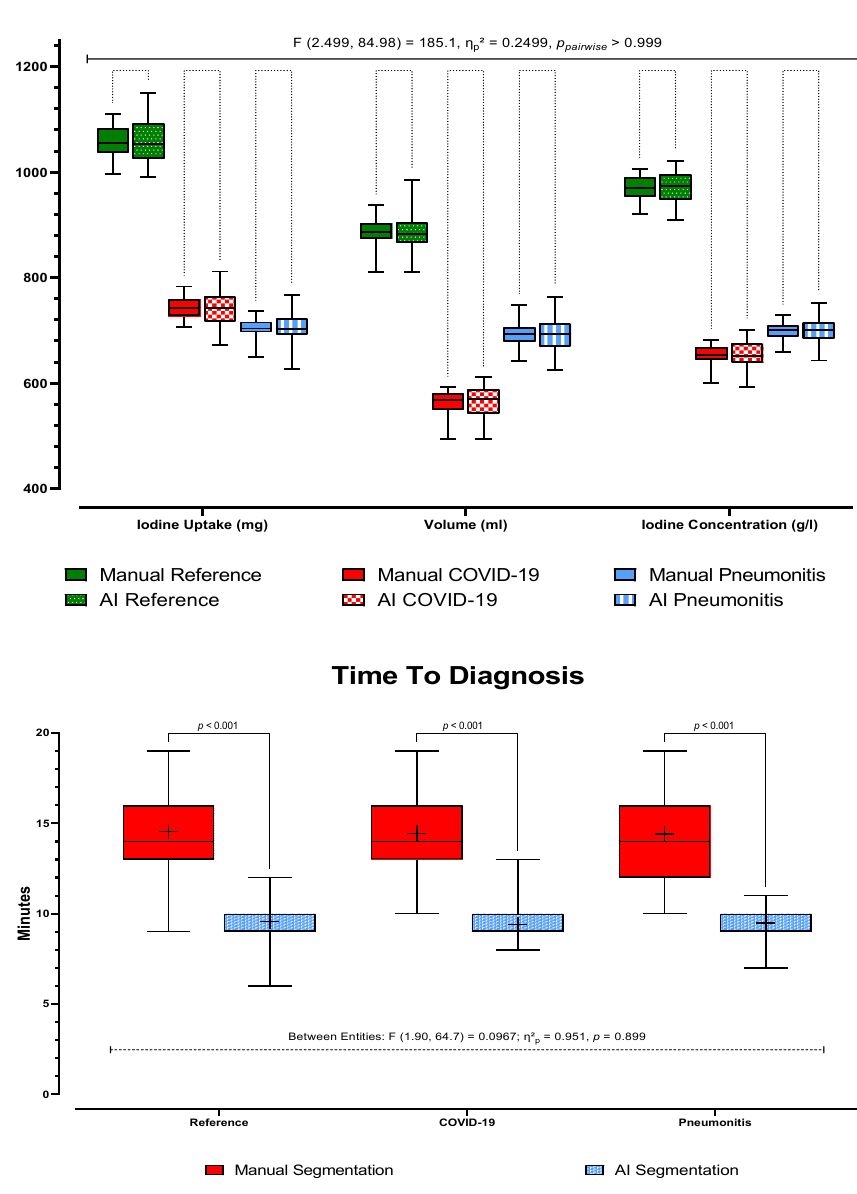
Figure 2. Comparison of extracted DECT metrics and time to diagnosis.